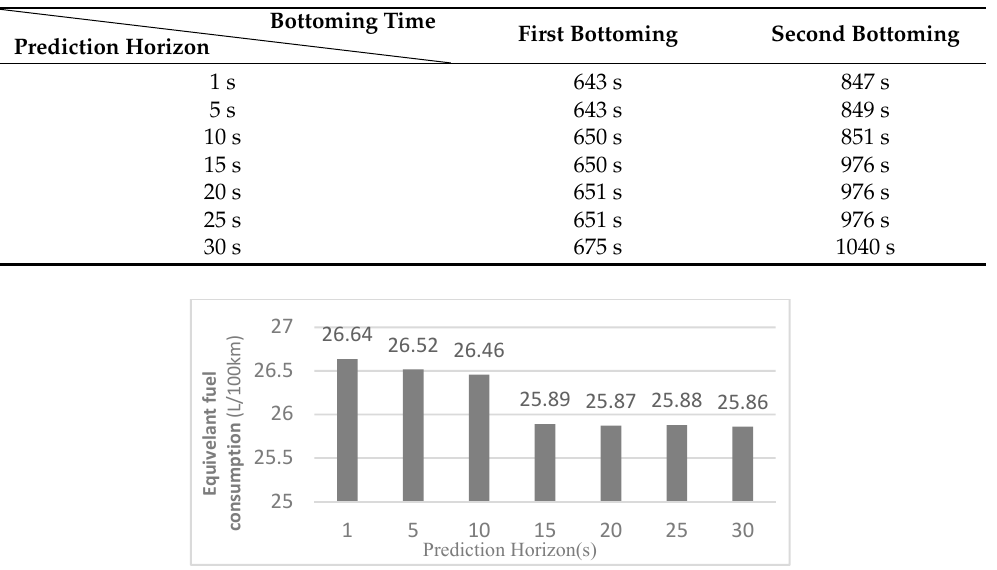
Table 8. SOC bottoming time under different prediction horizons.